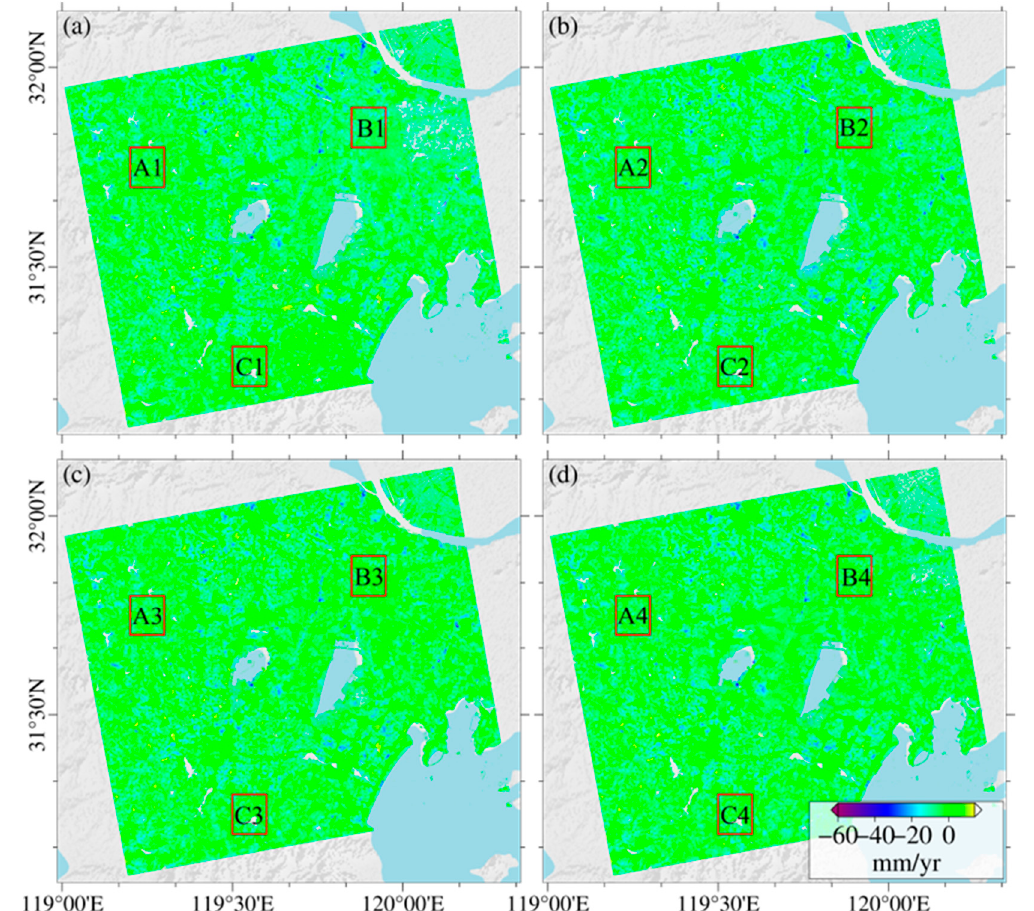
Figure A2. The deformation results in Changzhou obtained using the overlap ratio of ( a ) 10%, ( b ) 20%, ( c ) 30%, and ( d ) 40%. A1-C4 are the same areas as A-C described in Section 4.1.